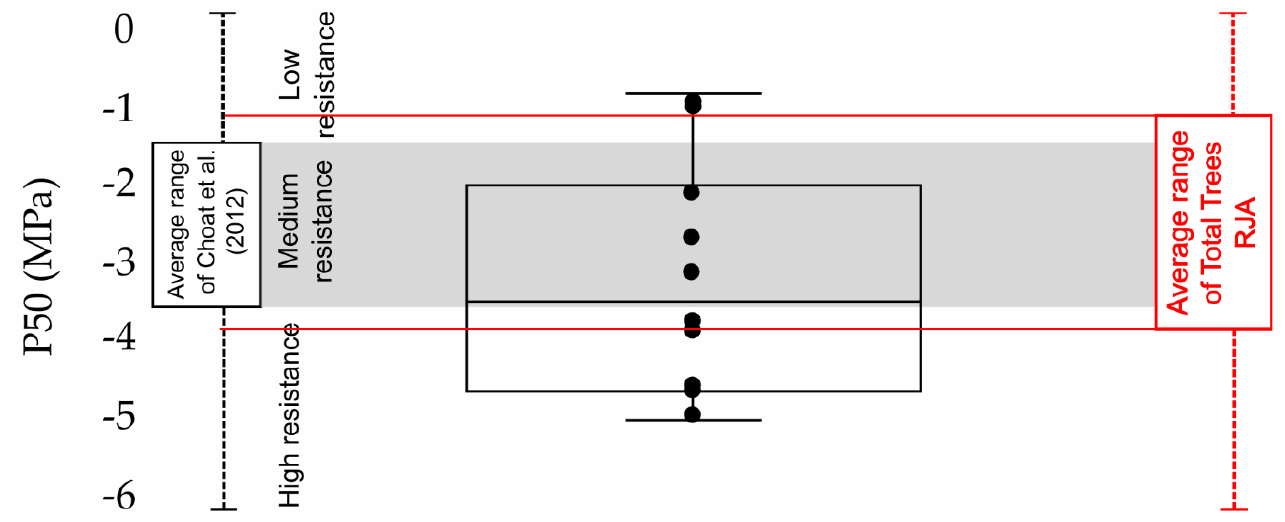
Figure 6. P 50 of species sampled in RJA and threshold based on [39].